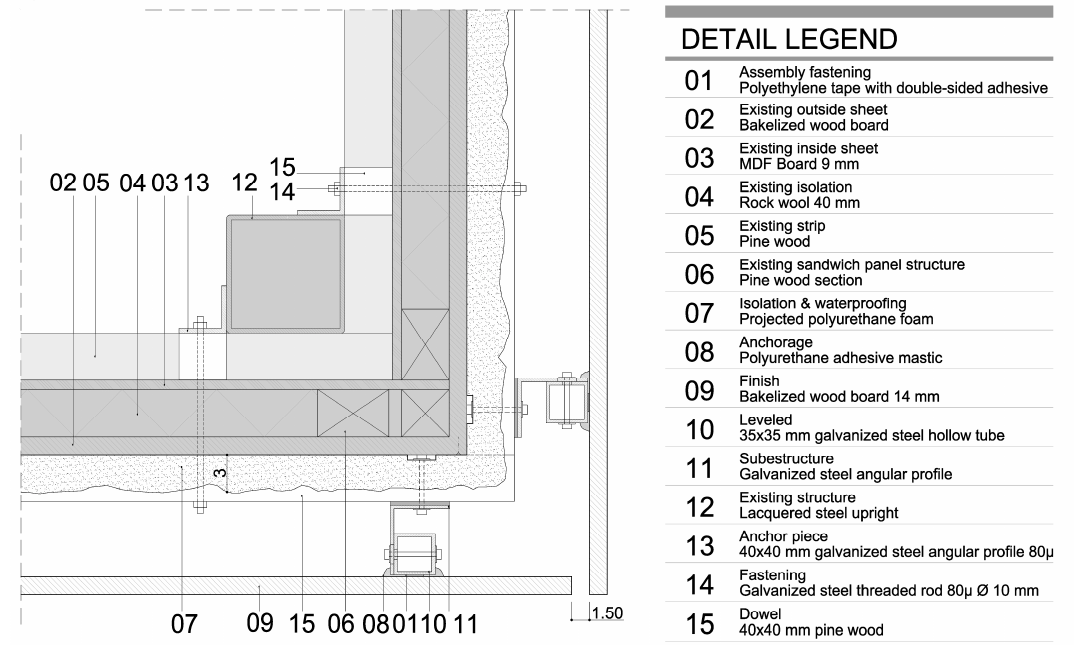
Figure 5. Constructive details of the MUA. Energy rehabilitation project.